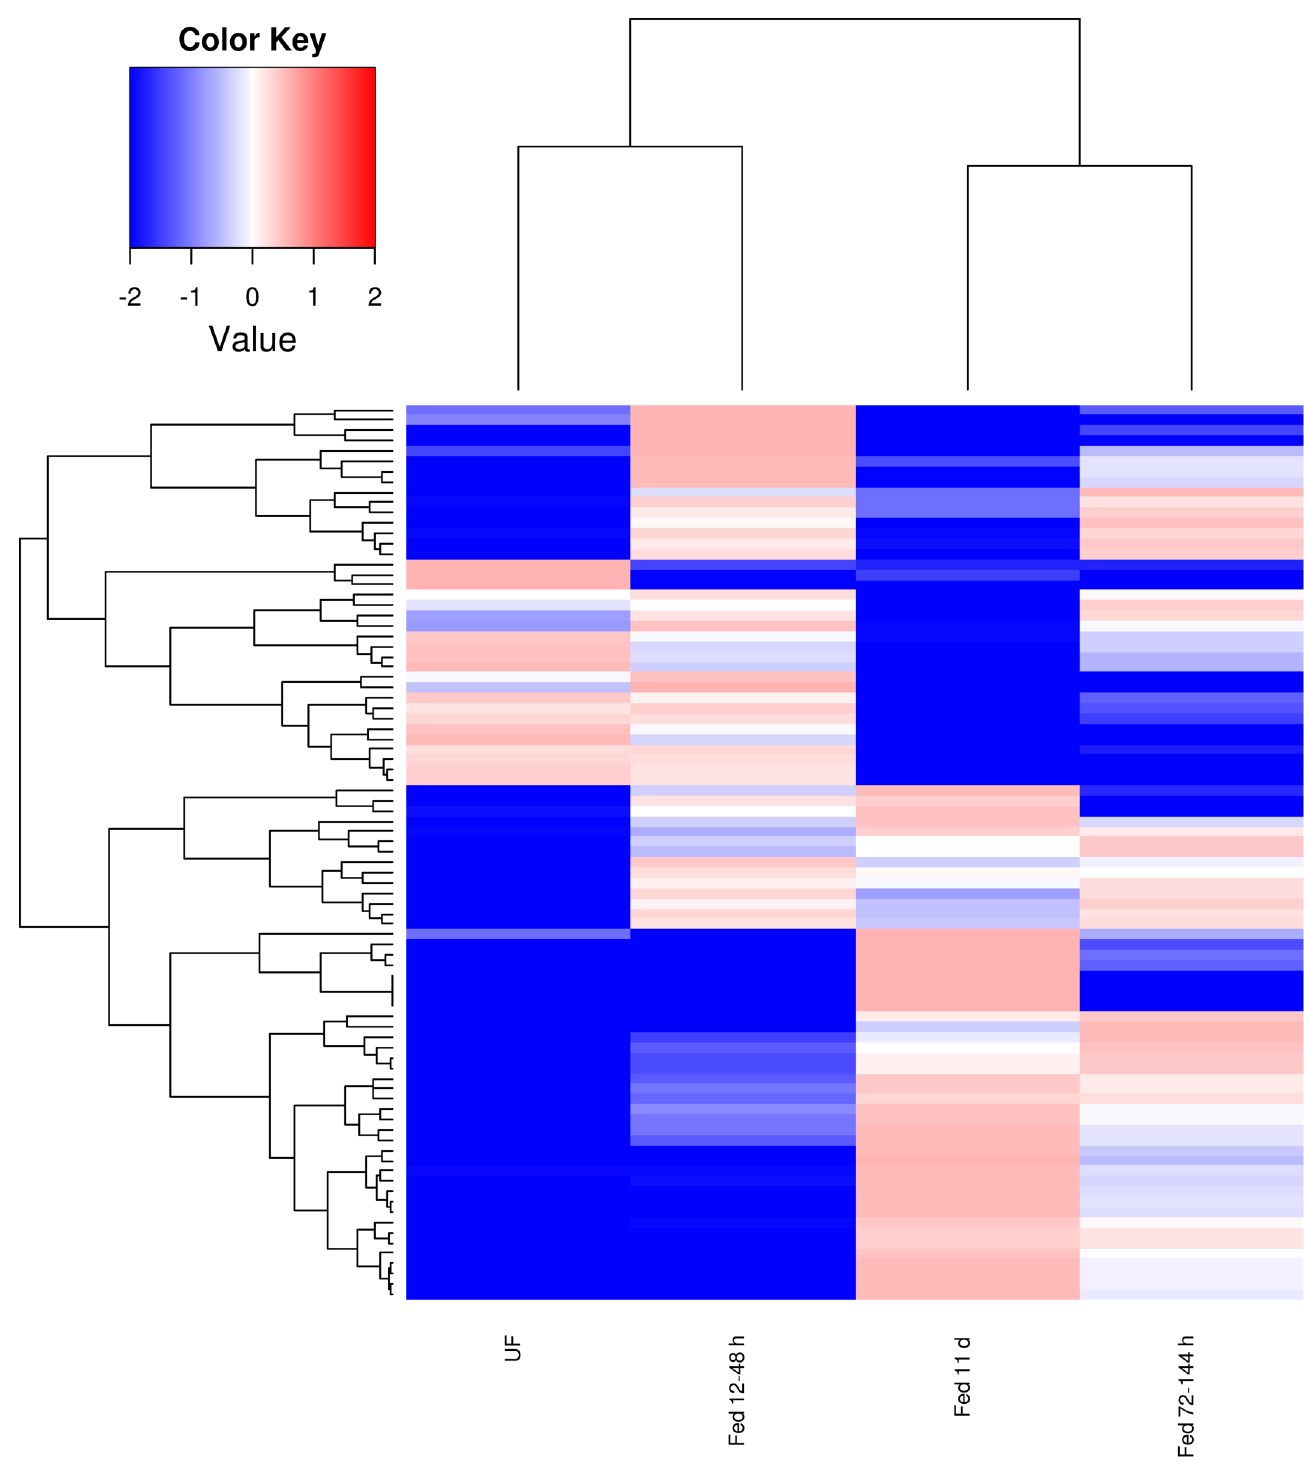
Fig 4. Heat map displaying 138 lipocalin coding sequences (CDS) that are not uniformly expressed in the four libraries and showing a standard deviation of 1 or more regarding the log(10) transformation of the average normalized data. For more details, see text.